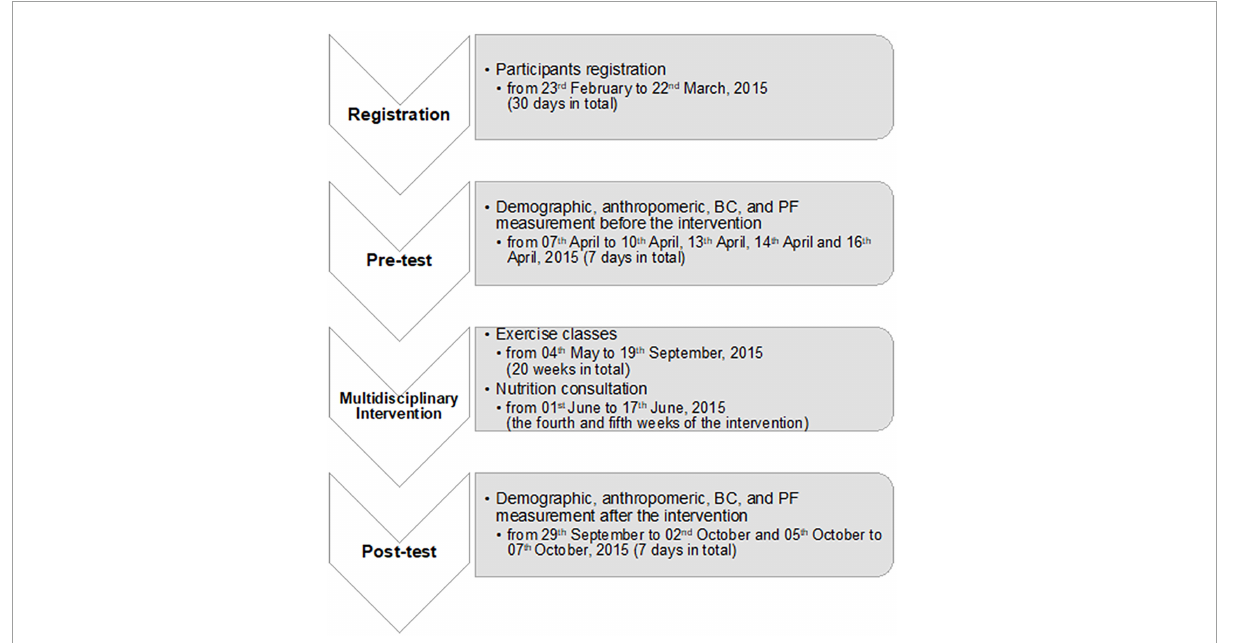
FIGURE1 Flow chart of the multidisciplinary. BC, body composition; PF, physical fitness.